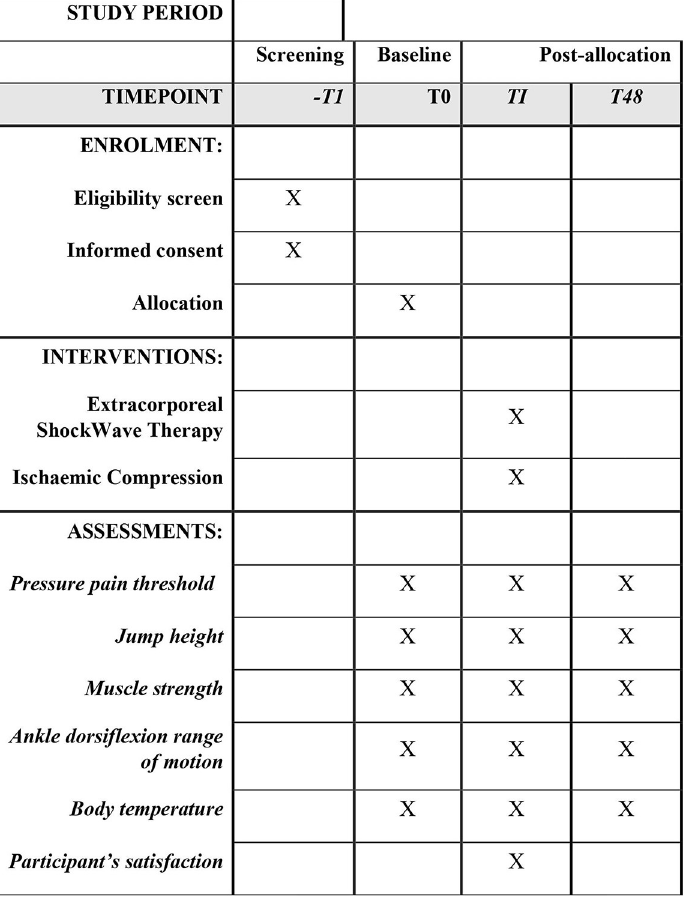
Fig 1. Standard protocol items: Recommendations for International Trials statement